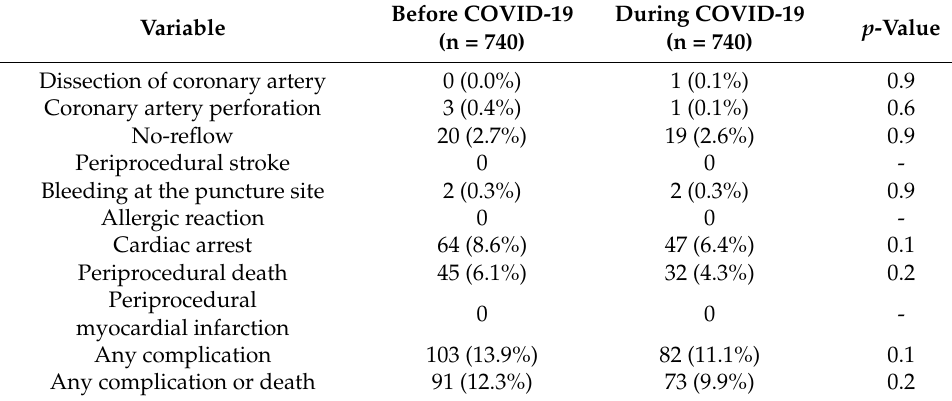
Table 5. Periprocedural complications after propensity score